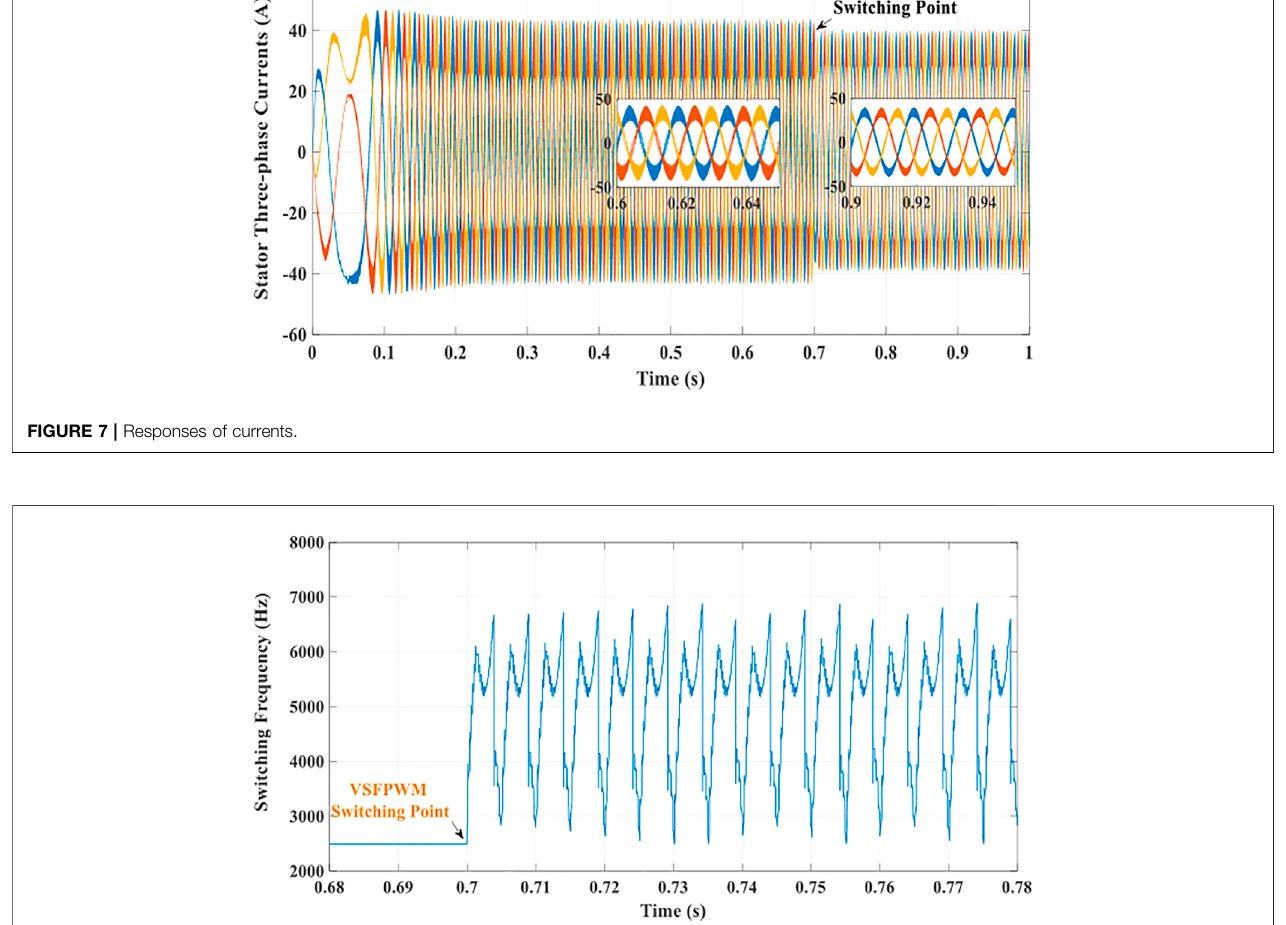
FIGURE 8 | Switching frequency variations.